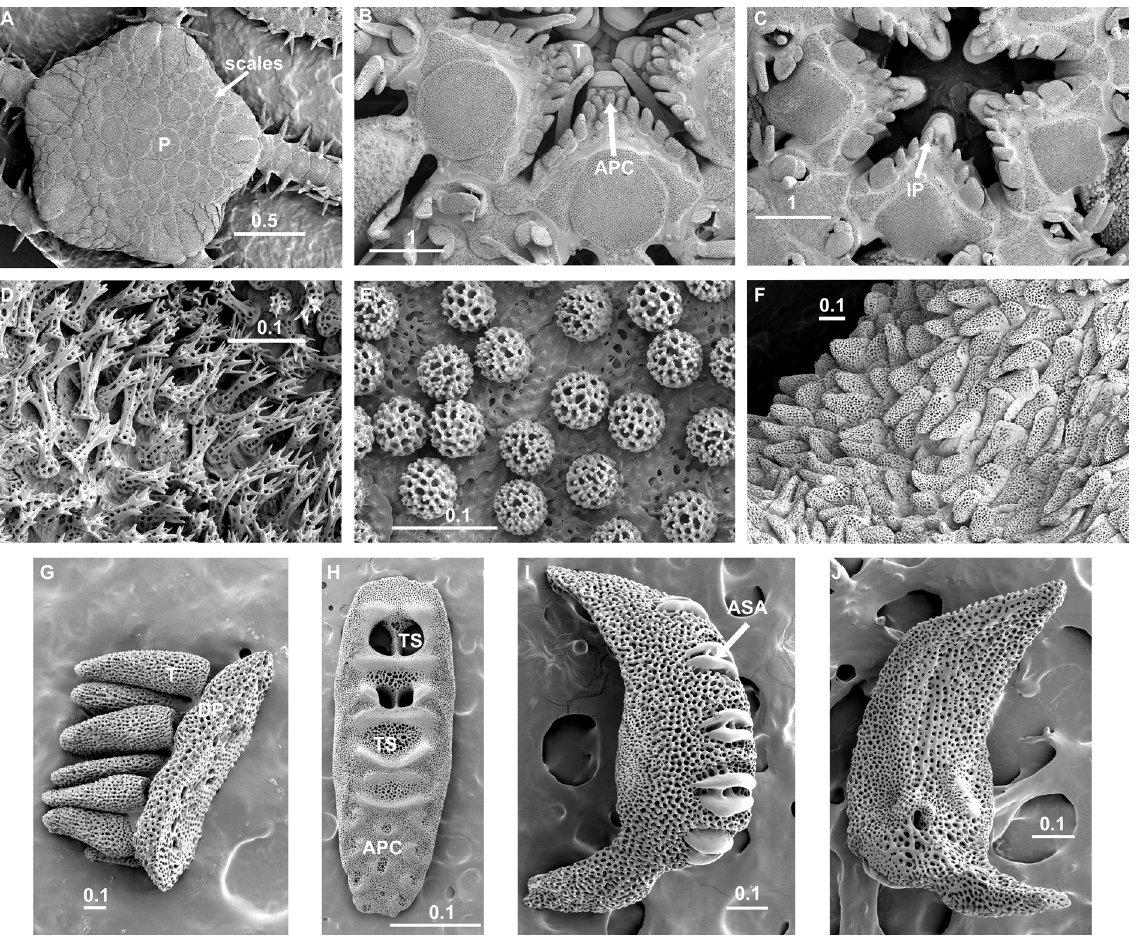
Fig. 2. Examples of skeletal structures of brittlestars. A . Dorsal disc with scales and plates in Amphiura Forbes, 1843 (P). B . Oral frame with teeth (T) and apical tooth cluster (APC) in Ophiocoma L. Agassiz, 1836. C . Oral frame with infradental oral papillae (IP) in Ophioplax Lyman, 1875. D . Disc spines in Ophiacantha Müller & Troschel, 1842. E . Disc granules in Ophiocoma L. Agassiz, 1836. F . Disc tubercles in Acrocnida Gislén, 1926. G . Dental plate (DP) in Ophiura Lamarck, 1801, with teeth attached. H . Dental plate with sockets for regular teeth (TS) and for apical tooth cluster (APC) in Ophiocoma L. Agassiz, 1836. I–J . Lateral arm plate in Amphiura Forbes, 1843. I . External view with arm spine articulations (ASA). J . Internal view. Scale bars